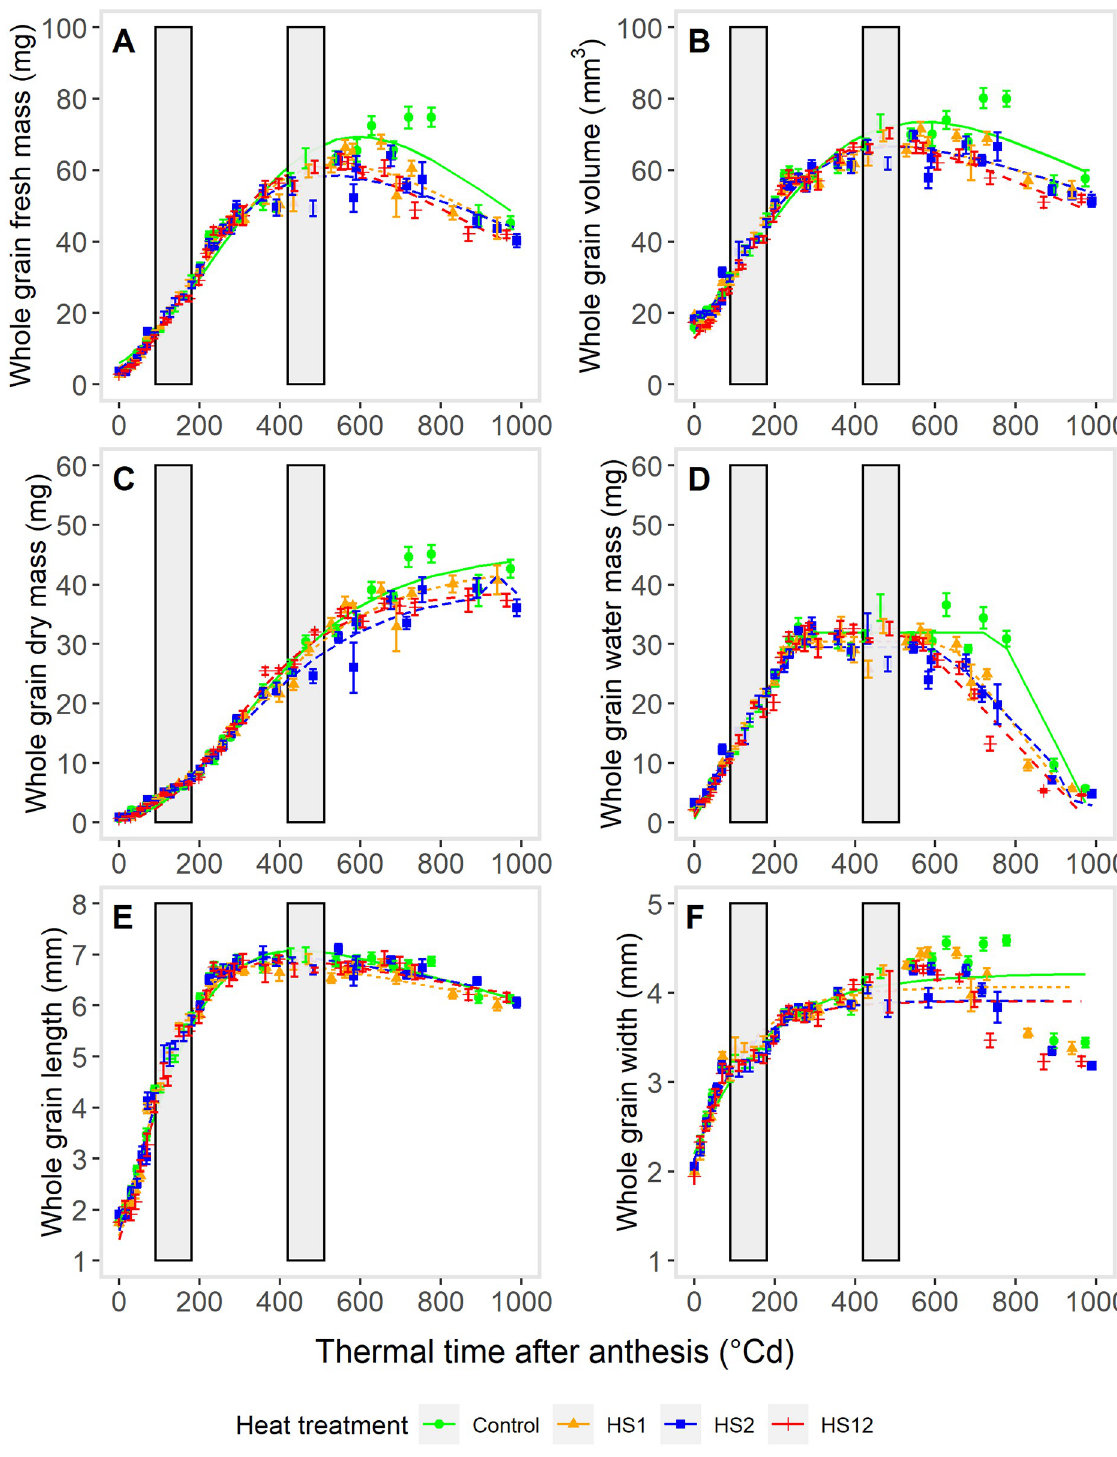
Fig 2. Effects of heat shocks on whole grain dimensions. Whole grain fresh mass (A), volume (B), dry mass (C), water mass (D), length (E) and width (F) during grain development after anthesis. Heat shocks (HS) were applied during the lag-phase (HS1), during the grain filling- phase (HS2) or during both the lag-phase and filling-phase (HS12) of the grain development, compared to Control. Each point corresponds to the mean of measurements on 10 basal grains from central spikelets sampled on 5 spikes. Lines represent the growth functions fitted to the observed values. Growth functions were selected on the base of the growth curves obtained for all treatments pooled (S2 Table). Vertical grey bars indicate the times and duration of exposure to heat shocks (~90˚Cd and ~420˚Cd after anthesis for respectively HS1 and HS2 during 4 days